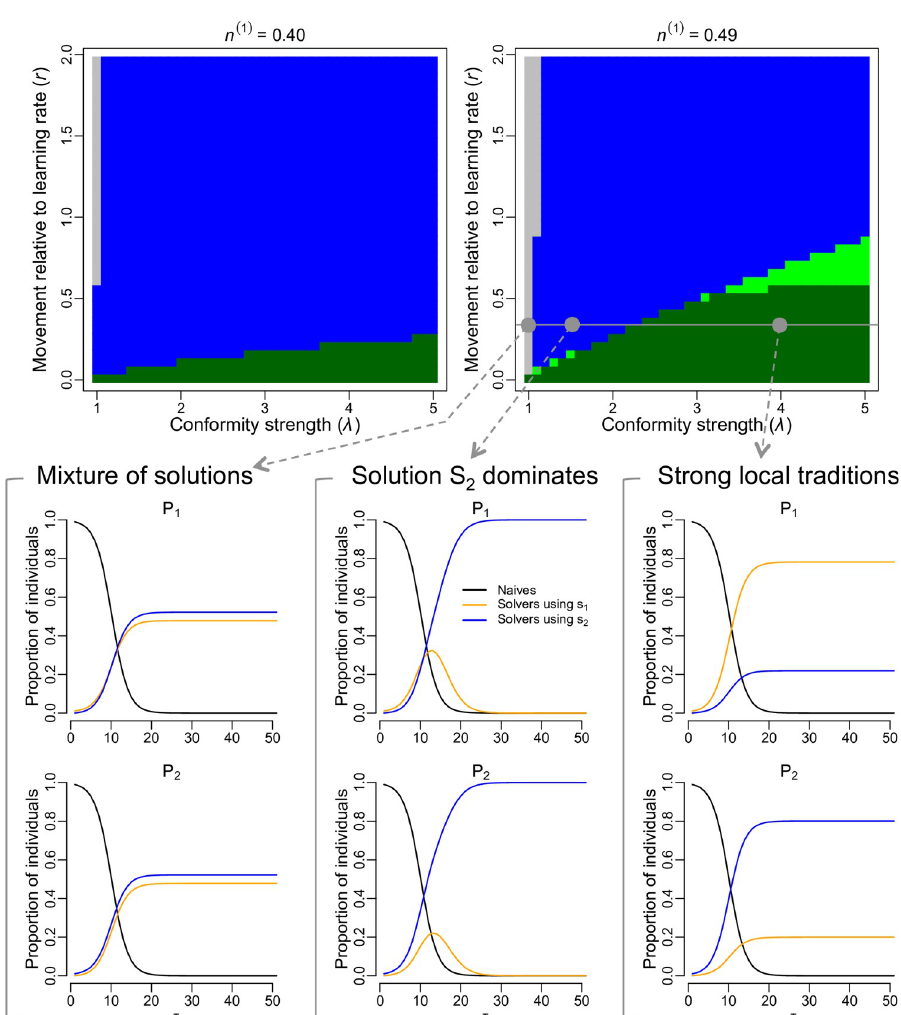
Fig 1. Local traditions emerge when conformity is strong relative to the movement rate. This panel shows the model outputs for the baseline model with two sub-populations. At the start of every simulation, sub-population P 1 contained innovators using solution s 1 (1% of its population) while sub-population P 2 contained innovators using solution s 2 (also 1% of its population). The phase diagrams represent different configurations of sub-population sizes, with n (k) indicating the proportion of the total population size in the system existing in sub-population P k . Each pixel in the phase diagrams derives from a simulation run with the corresponding parameter values, and the colour of the pixel indicates the emerging pattern after 150 days: grey = mixture of solutions in every sub-population, blue = solution s 2 dominated the whole system, light green = weak local traditions, dark green = strong local traditions (see section Analysing emerging patterns in Materials and Methods for details). Three examples of the evolution of the proportion of na ï ve individuals (black curve) and proportion of solvers using solution s 1 (orange curve) and solution s 2 (blue curve) in each sub-population, are shown for fixed movement rate relative to the learning rate ( r = 0.35) and sub- population size configuration, but with varying conformity strength. When no conformity bias was included ( λ = 1), sub-populations had a mixture of solutions; when conformity was relatively weak ( λ = 1.5), solution s 2 (which was seeded in the larger population) dominated both sub-populations; and when conformity as relatively strong ( λ = 3.5), local traditions